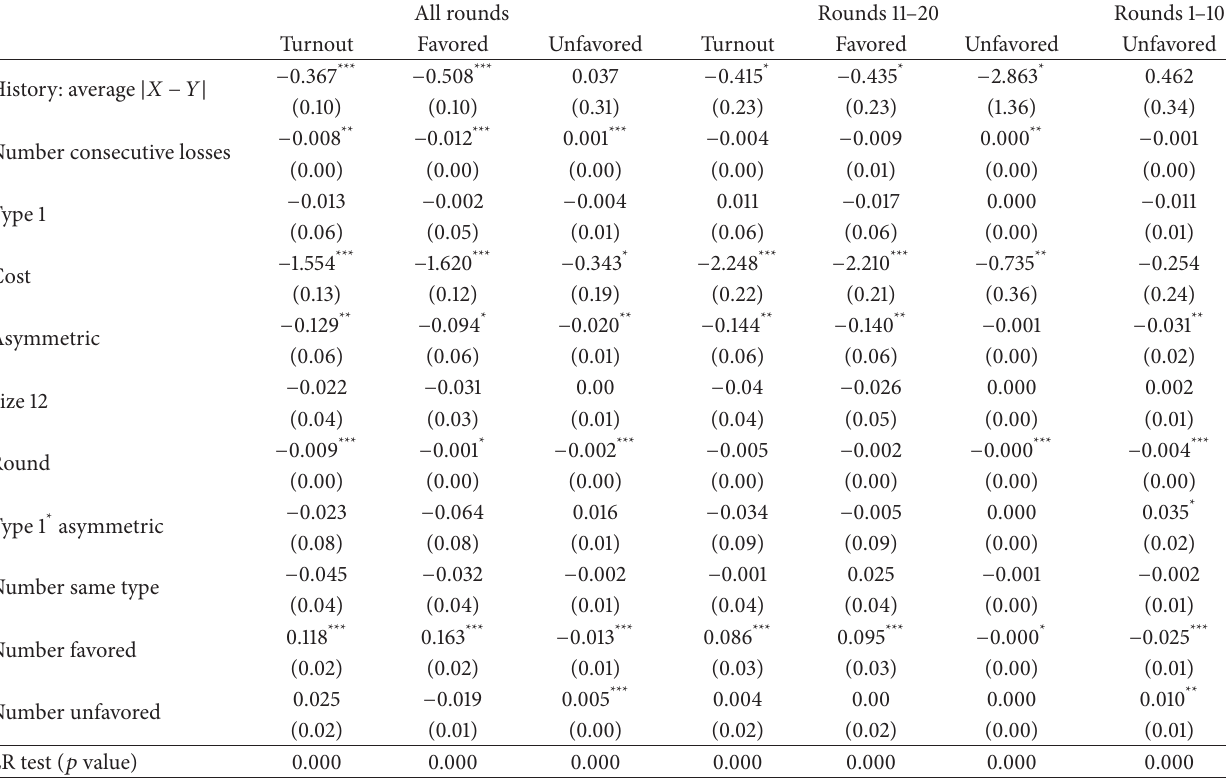
Table 7: Logit with subject-level random effects and cluster-robust standard errors (marginal